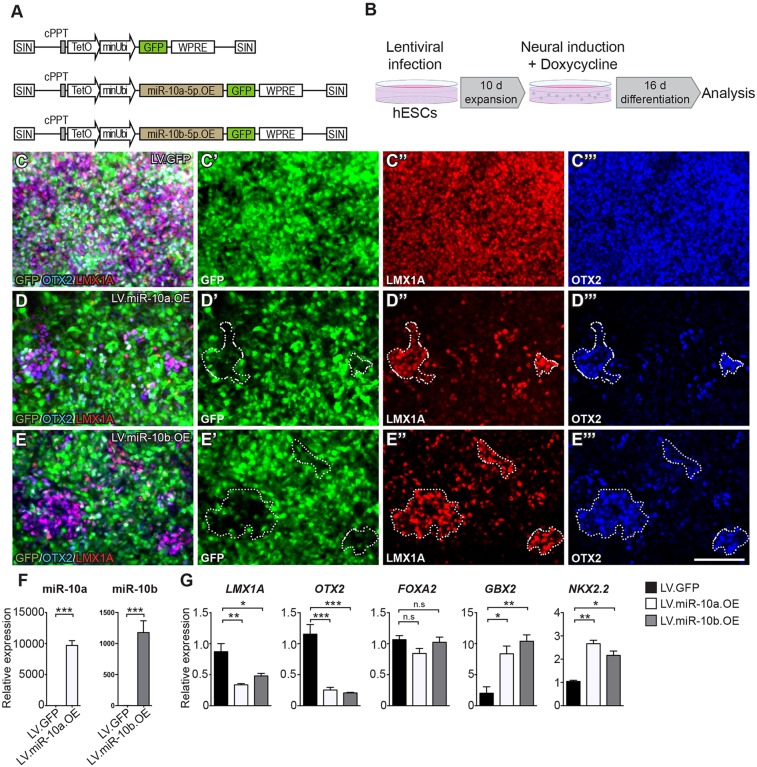
Overexpression of miR-10a and miR-10b caudalizes MB-patterned human neural progenitors. (A) Illustration of the proviral form of LV.GFP, LV.miR-10a.GFP and LV.miR-10b.GFP. (B) Schematic overview of the workflow showing that hESCs were transduced with lentiviral vectors followed by 10 days of expansion. Doxycycline was added to the media during differentiation and cells were analysed at day 16. (C-E‴) OTX2 and LMX1A are expressed in the vast majority of cells infected with LV.GFP (C-C‴), but only in a small proportion of the cells in which miR-10a or miR-10b are overexpressed (D-E‴). (F) The miR-10a and miR-10b expression was investigated using LNA-RT-qPCR at day 16 of differentiation, showing that miR-10a and miR-10b are strongly expressed in cells infected with LV.miR-10a.GFP and LV.miR-10b.GFP, respectively. (G) qRT-PCR of cells after 16 days of MB patterning revealed that cells overexpressing miR-10a or miR-10b had been caudalized in comparison to control cells. The MB markers LMX1A and OTX2 decreased while the expression of the anterior HB marker GBX2 increased. The expression of NKX2.2 was also increased. Expression levels of FOXA2 were unaffected, which correlates with the fact that FOXA2 is expressed in both MB and HB during human development. All qRT-PCR analyses were performed using three biological and three technical replicates. Data are presented as mean±s.e.m. *P<0.05, **P<0.005, ***P<0.0005. Scale bar: 100 μm.